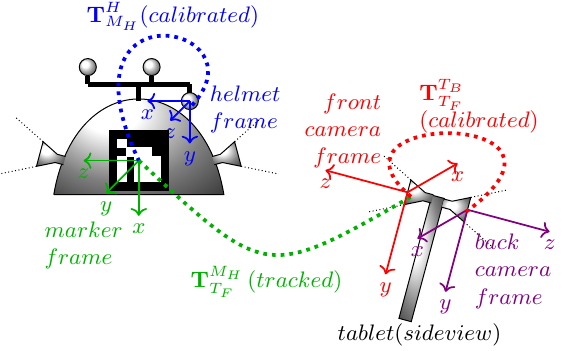
Figure 3. Tracking the relative pose between tablet and helmet by observing markers displayed on the tablet screen from the helmet cameras.